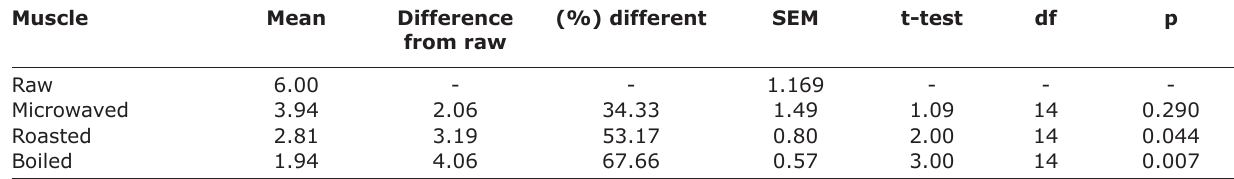
Table-1: Comparison of inhibition zones between raw muscles and different cooking methods at pH 6.0. Muscle Mean inhibition zone (mm) Raw Microwaved Boiled SEM=Standard error of the mean Table-2: Comparison of inhibition zones between raw muscles and different cooking methods at pH 7.2. Muscle Mean Raw